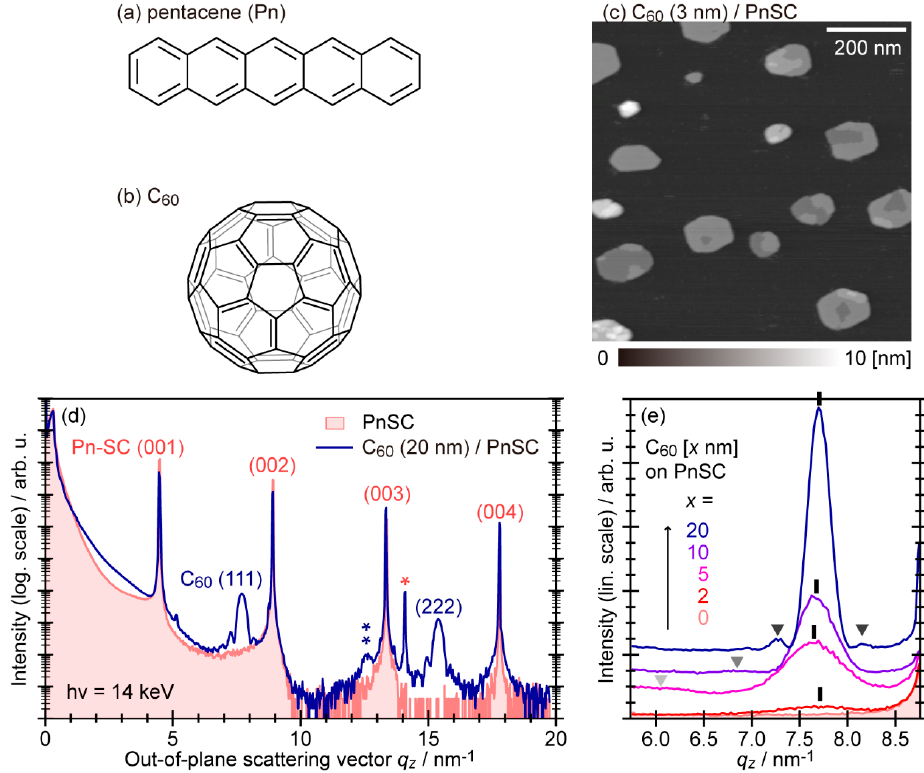
Figure 3. ( a ) Molecular structure of Pentacene. ( b ) Molecular structure of C 60 . ( c ) AFM topography of 3 nm-thick C 60 deposited on a PnSC substrate. Single and double asterisk marks were ascribed to signals from misoriented crystallites. ( d ) Out-of-plane XRD profiles of a PnSC sample before (red) and after (blue) coverage of 20 nm-thick C 60 . ( e ) Evolution of the XRD profiles depending on the C 60 thickness on PnSC. ( c – e ) cited from [37].